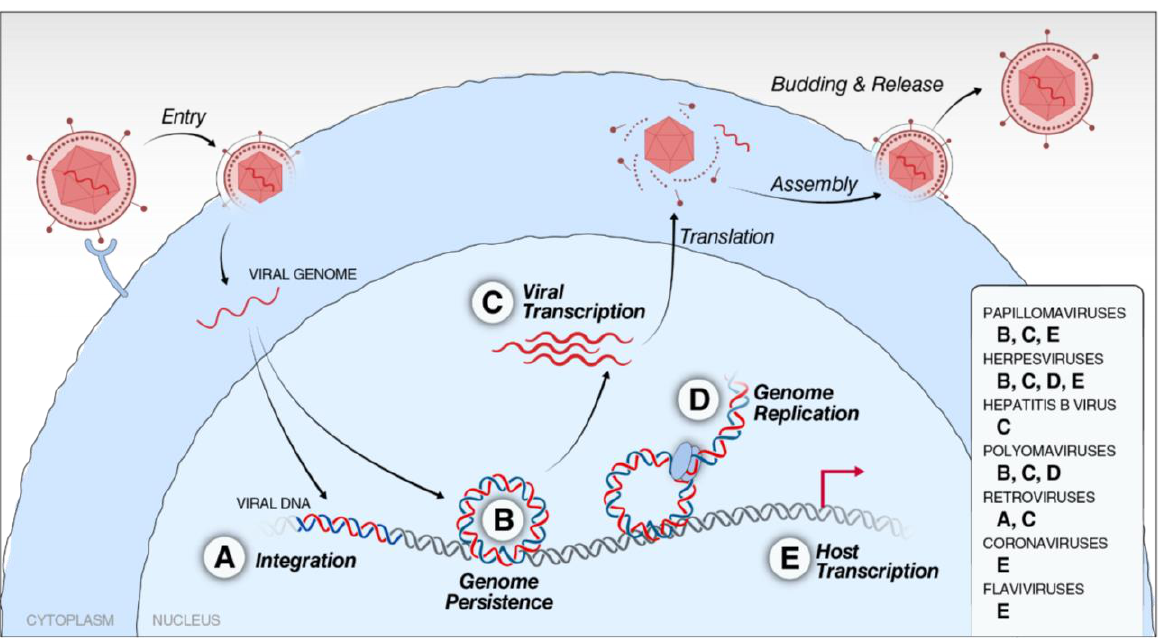
Figure 2. Steps in a generic viral life cycle where BET proteins are involved. Many viruses interact with BET family members to mediate viral processes (A–D) and disrupt cellular transcription for their own benefit (E). (A) Integration site selection of MLV, a gammaretrovirus, is facilitated by an interaction between its viral IN protein and BET proteins, leading to integration into genomic regions associated with BET proteins. (B) PV, herpesviruses, and polyomaviruses take advantage of the association of BET proteins to host chromosomes to maintain their viral genomes in infected cells. (C) Certain herpesviruses (EBV and HSV), PV, HBV, and polyomaviruses recruit the BRD4:P-TEFb complex to facilitate viral transcription, while retroviruses encode viral proteins that directly bind the PID of BRD4 to redirect host transcriptional machinery to the viral genes. (D) Herpesviruses and polyomaviruses recruit BRD4 along with other host replication machinery, such as RFC or DNA polymerase δ, facilitate genome replication at their replication foci. (E) PV, Herpesviruses, SARS-CoV-2, and flaviviruses interact with BET proteins to disrupt homeostatic gene transcriptional programs controlled by BET proteins during infection to generate a cell state more favorable to viral replication and virus-induced carcinogenesis.